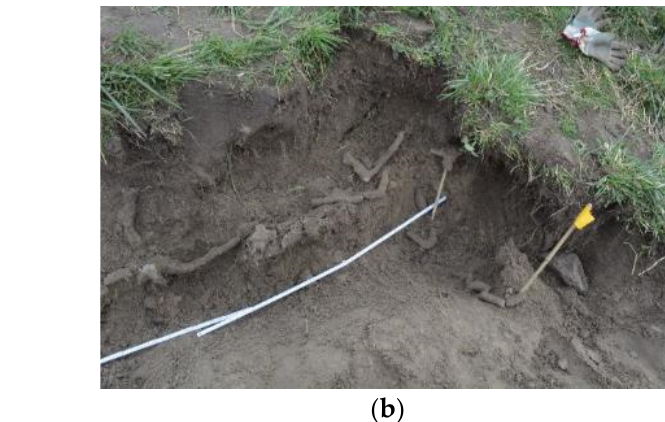
Figure 10. ( a , b ) Examples of excavated grouted animal burrows.